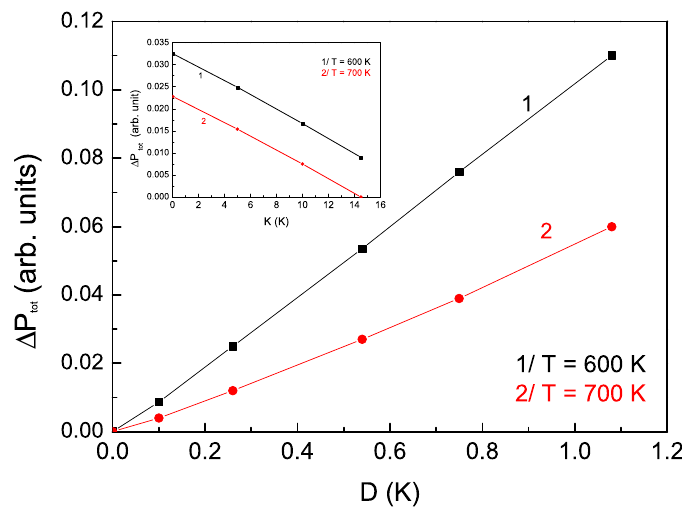
Figure 5. Dependence of the total spin-assisted polarization ∆ P tot on the DM vector D and in the inset on the anisotropy constant K for different temperatures T = 600 (1) and 700 K (2).